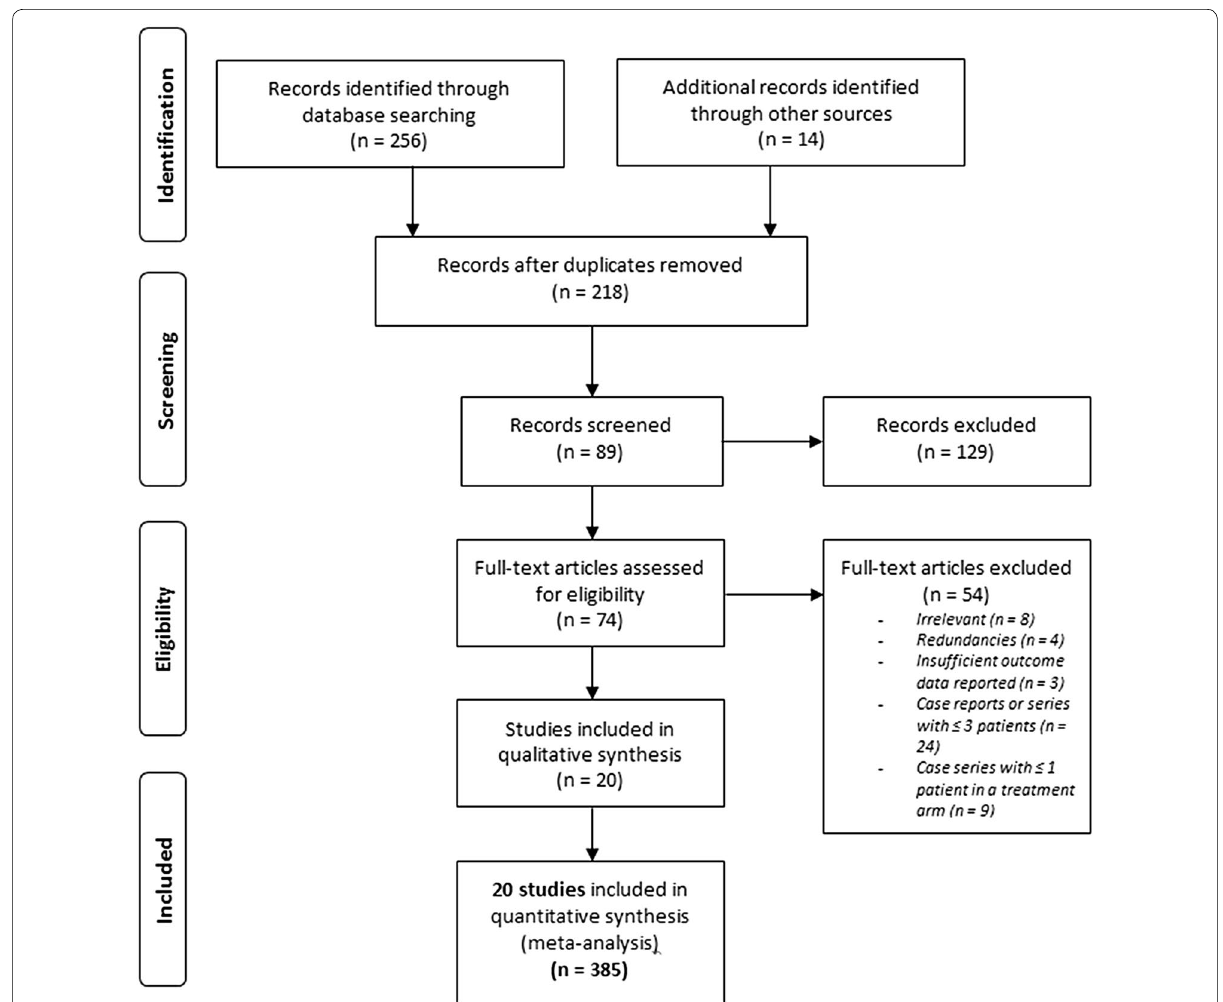
Fig. 1 Flowchart of selected studies, according to PRISMA